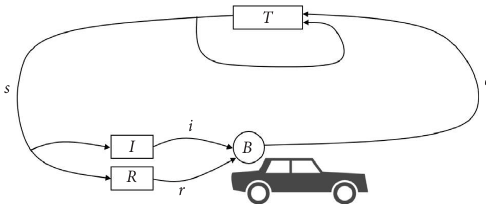
Figure 1: Reinforcement learning model. Te vehicle interacts with the environment via trial-and-error